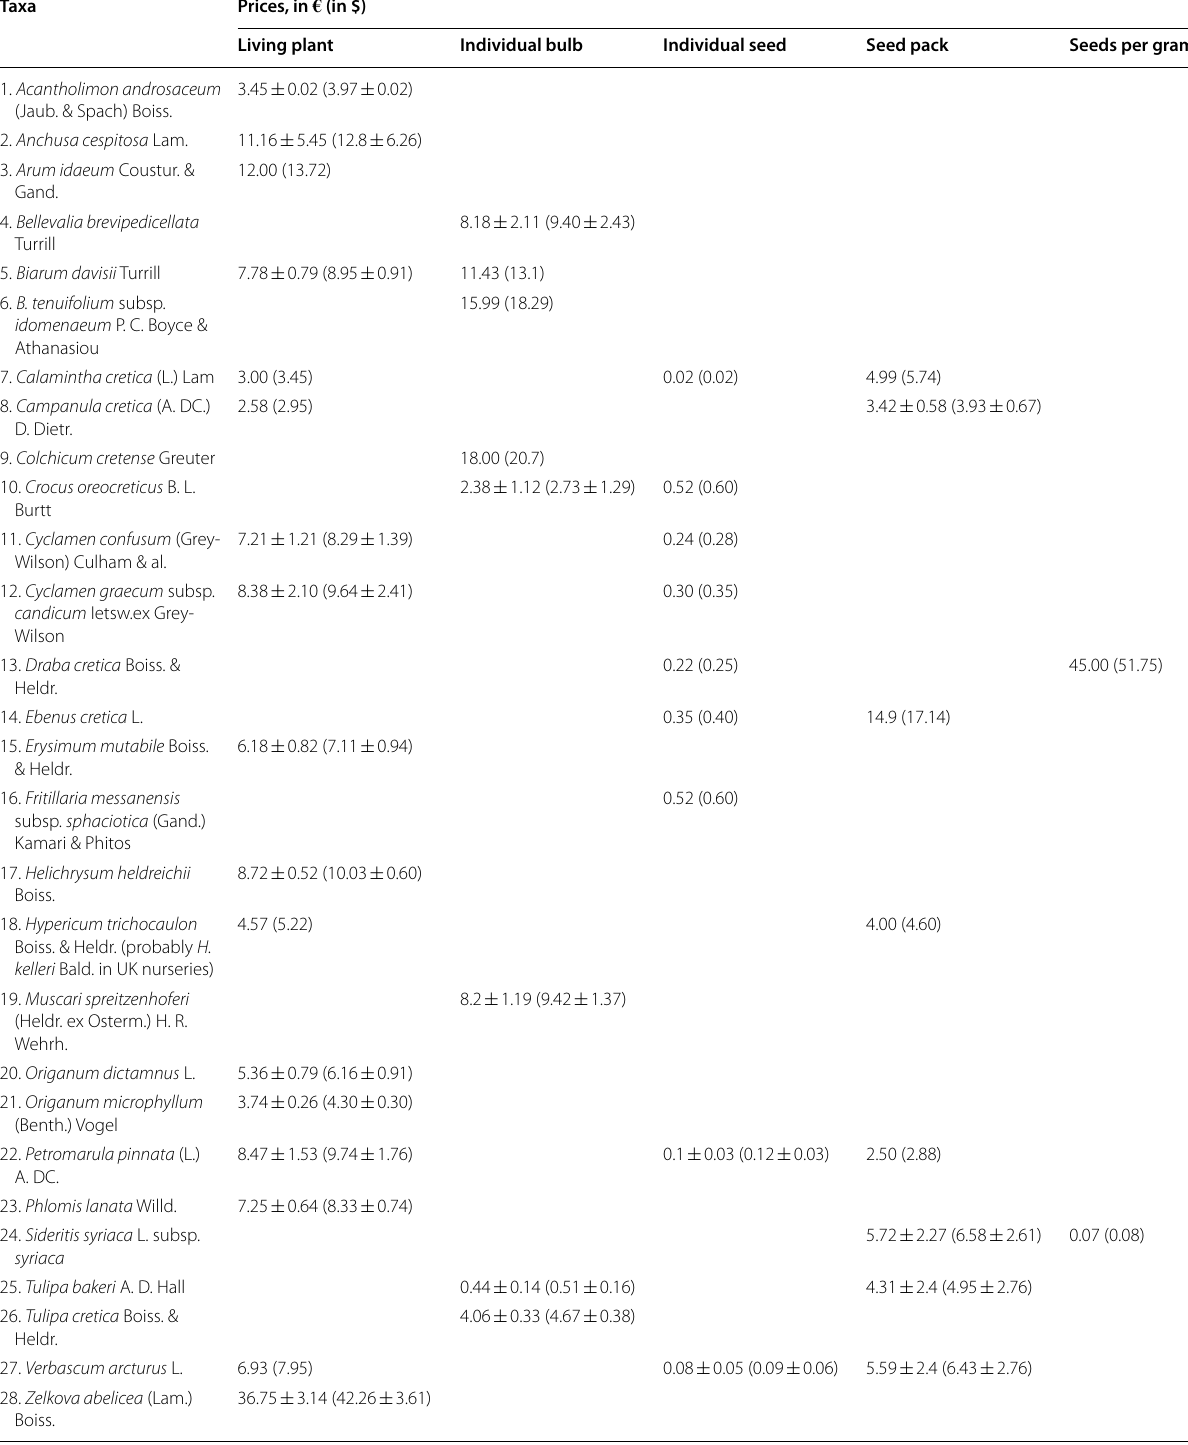
via the Internet as living plants, bulbs and/or